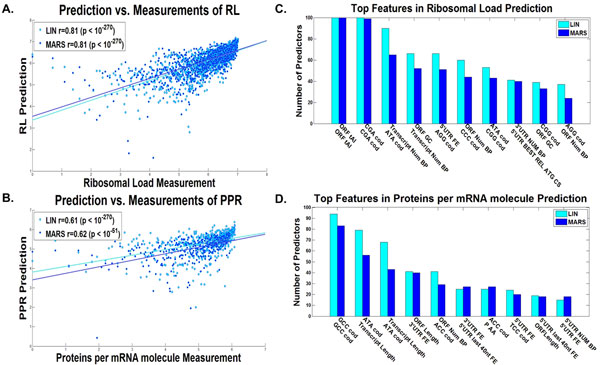
Entire Transcript linear and non-linear predictors results. Dot plot of the predictions vs. estimated measurements for the validation set of the predictor with the median results for the A. ribosomal load, and B. proteins per mRNA molecule, for the entire transcript, for the combined linear (LIN) and non-linear (MARS) predictors (Additional file 1: Supplementary Methods). The best features according to the number of predictors they participated in (Additional file 1: Supplementary Methods) of the C. ribosomal load predictor, and D. proteins per mRNA molecule predictor, for the entire transcript, for the combined linear (LIN) and non-linear (MARS) predictors (Additional file 1: Supplementary Methods).